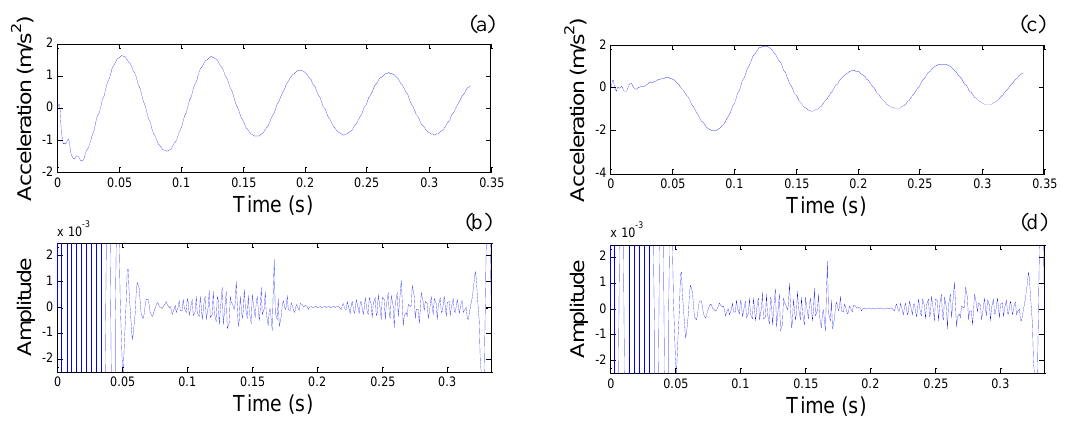
Fig. 3. (a) IMF 1 and (b) filtered IMF 1, (c) acceleration signal and (d) filtered acceleration